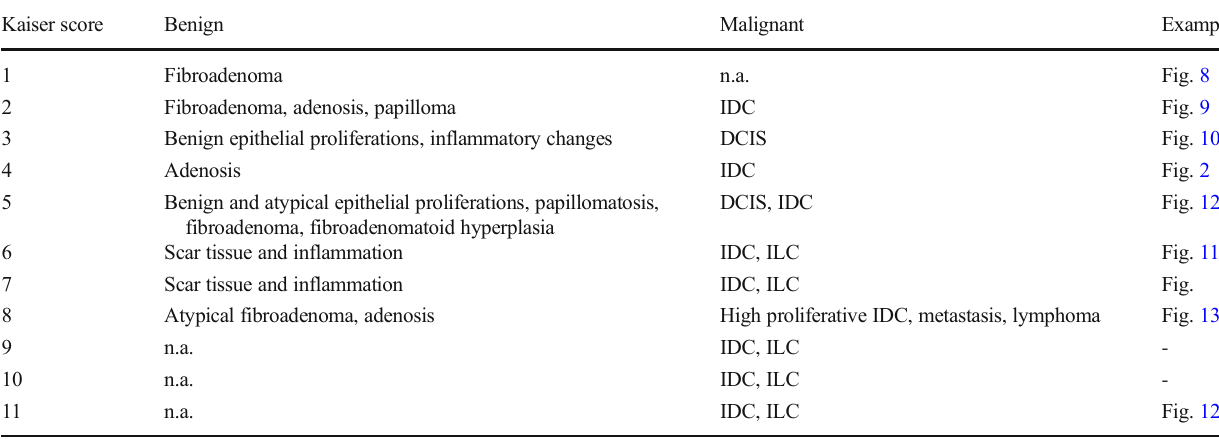
Kaiser score categories and their typical histopathological correlates Kaiser